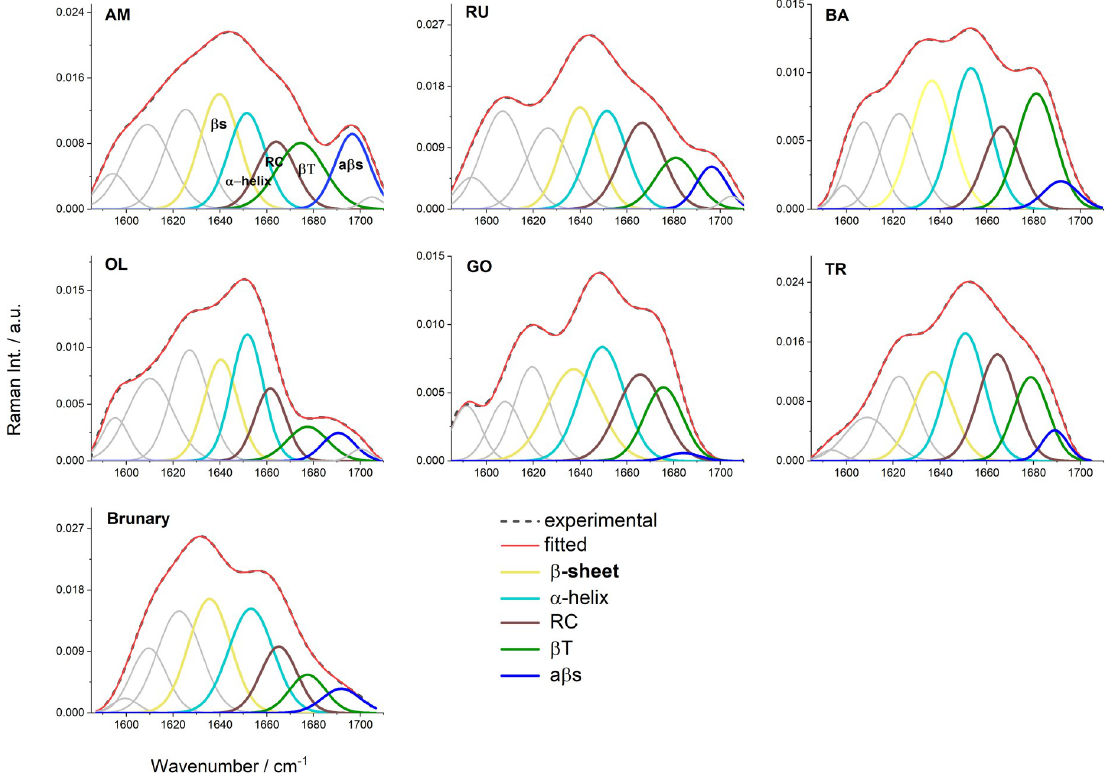
Fig 5. Curve fitting of the FT-Raman spectra in the range of amide I obtained for Bet v1 protein, deriving from the studied areas. RU–Ruczaj, BA–Batowice, AM–al. Mickiewicza, OL–Olkusz, TR–Trzebinia, GO- Gorlice, BR–Brunary.